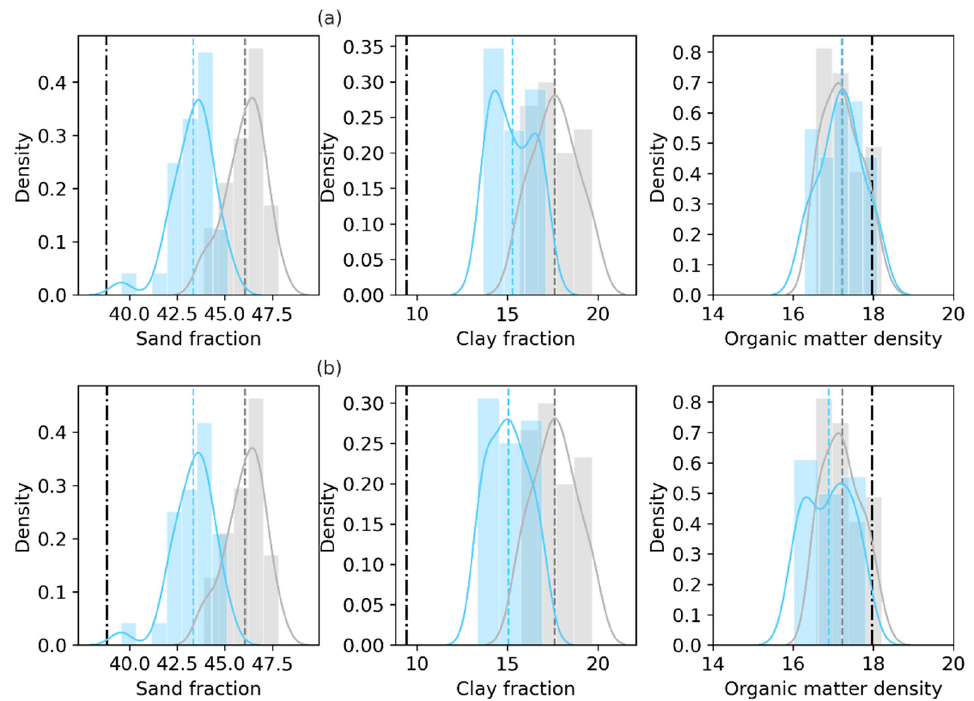
Figure 4. Same as Figure 3, but based on the experiments with SMAP 𝑇 (cid:3003)(cid:3023) assimilation. The top panel labeled ( a ) displays the Only_Para experiment results based on SMAP 𝑇 (cid:3003)(cid:3009) assimilation. The bottom panel ( b ) displays the Joint_Updt experiment results. In each subfigure, gray indicates the prior, light blue indicates the posterior, and the black dash-dotted line indicates the laboratory measurements.